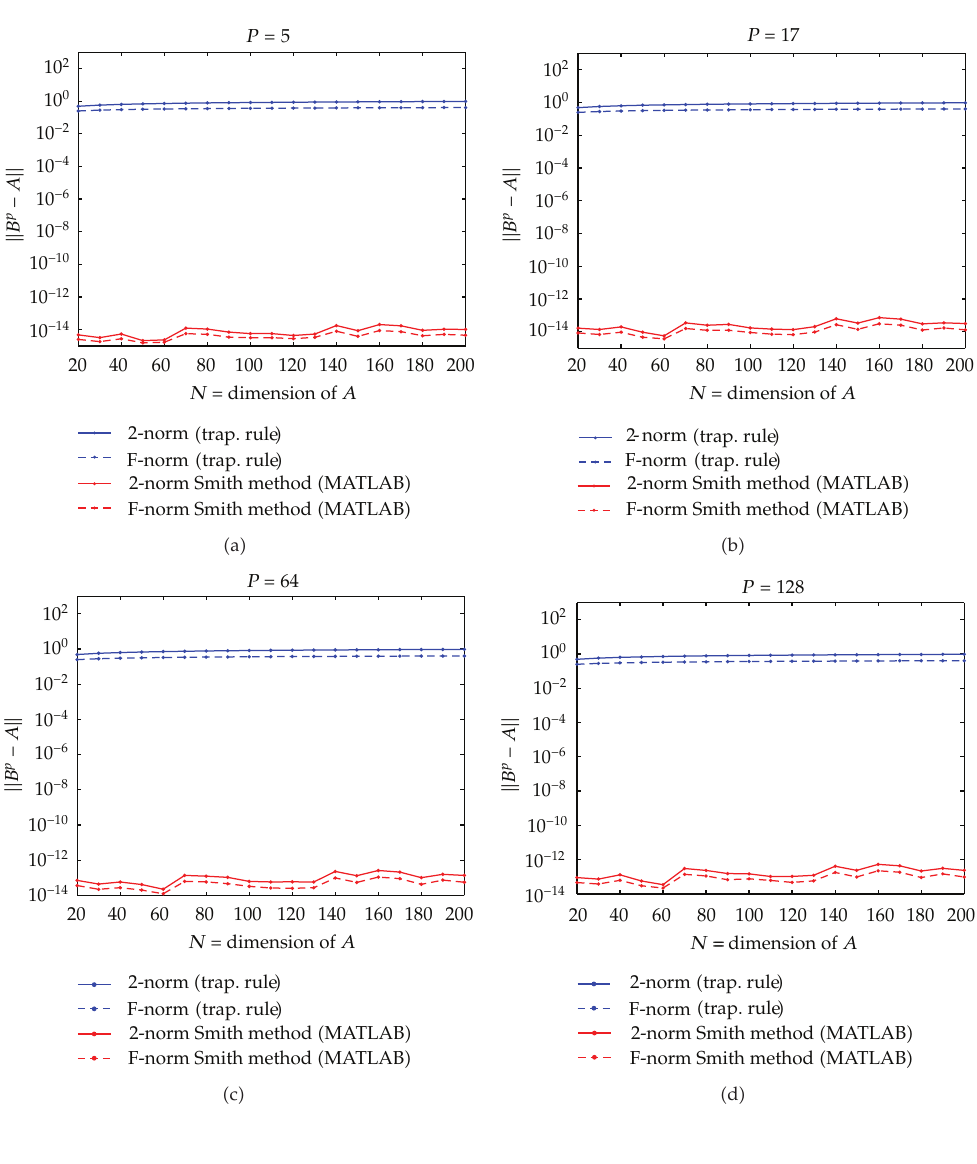
Figure 4: Residual error for computing A 1 /p for Hilbert matrix.